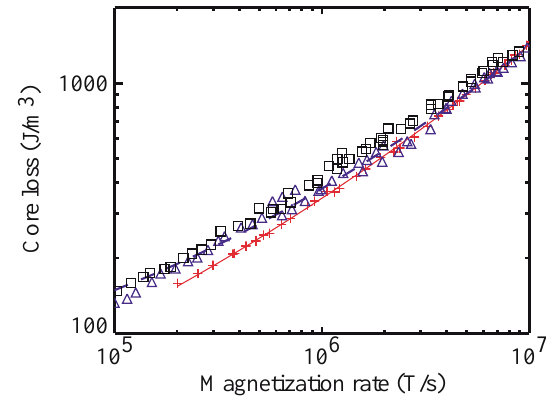
FIG. 10. (Color) Core loss versus magnetization rate for three METGLAS 2605 SC cores, The data are for the listed flux swings: ( (cid:1) , black) MRTI SC-02 at 2.25 T; ( (cid:3) , blue, dashed line) MRTI SC-01 at 2.20 T; and ( 1 , red, line) Mica-C14 at 2.25